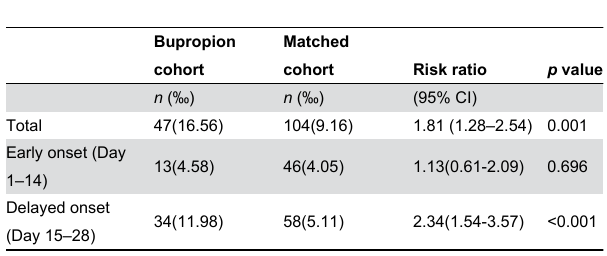
Table 4. Analyses of risk factors for urticaria in depressive patients after bupropion use.